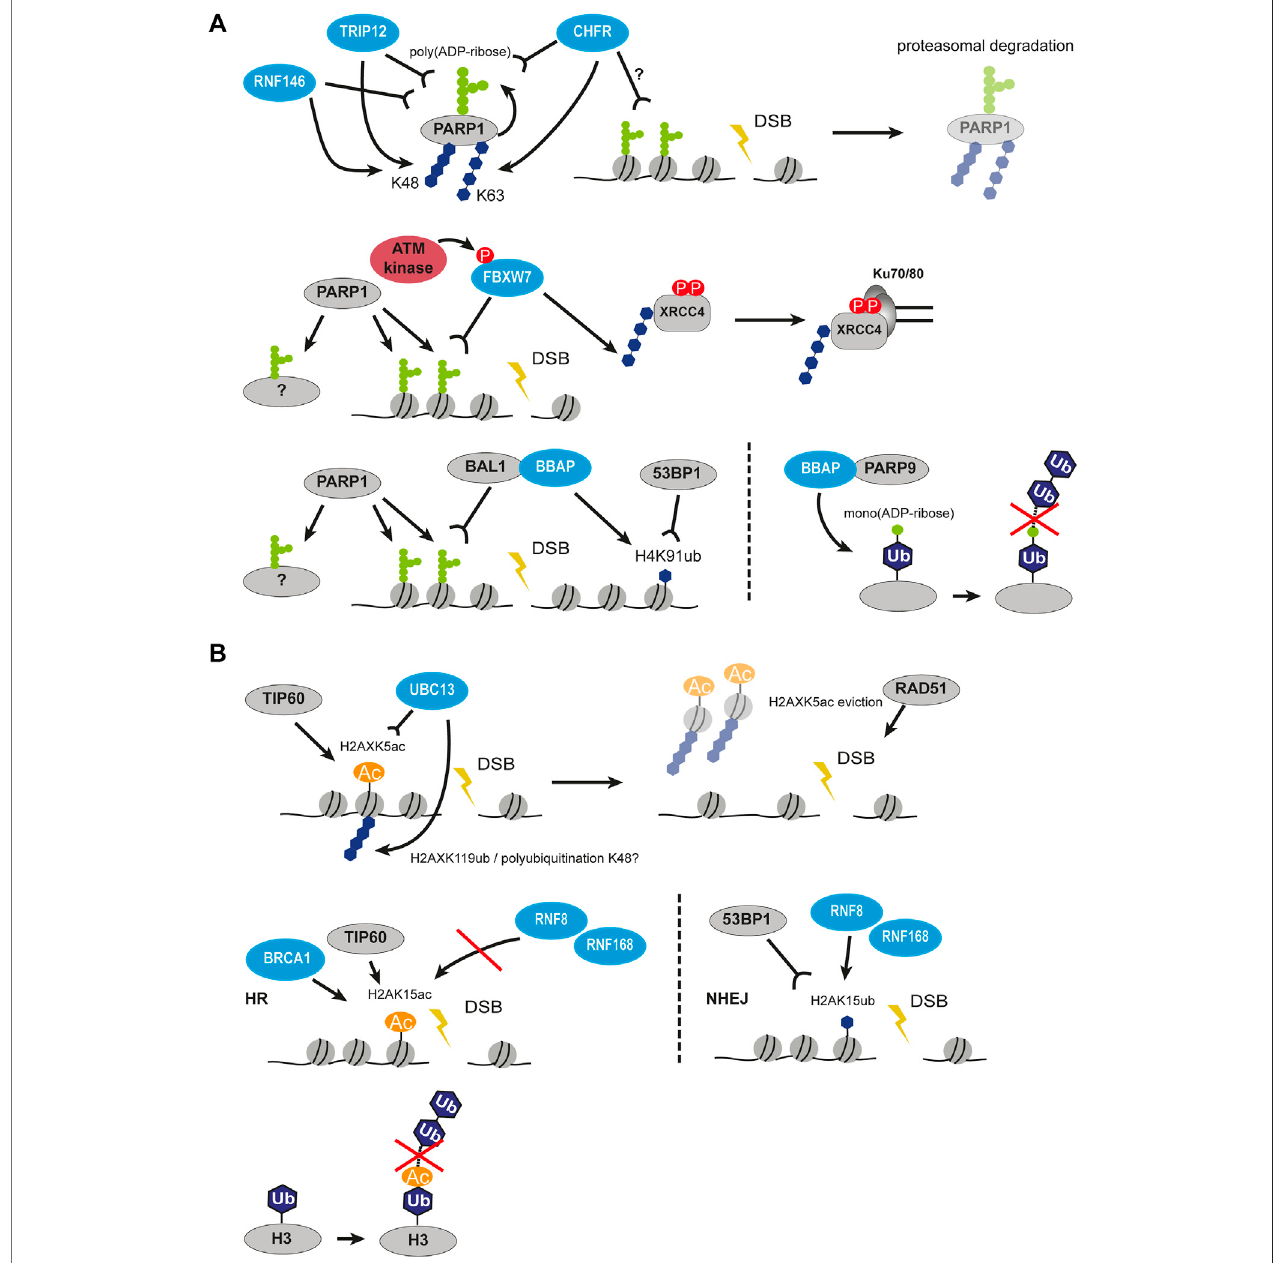
FIGURE 5 | Crosstalk between PARylation and ubiquitination, as well as acetylation and ubiquitination in DSB signaling and repair. (A) Crosstalk between PARylation and ubiquitination. PARP1 auto-PARylates itself followed by recognition of PAR chains by several ubiquitin ligases such as CHFR, RNF146, TRIP12 and subsequent polyubiquitination. This results in proteasomal degradation of PARP1. PARP1-mediated modi fi cation of histones at DSBs can be recognized by FBXW7, whichpolyubiquitinates XRRC4 and leadstoits interaction with Ku70/80. On theother hand,PARP1-mediated modi fi cation ofhistonescanalso berecognized by BAL1-BBAP which leads to ubiquitination of H4K91 creating a binding site for 53BP1. Interaction of BBAP with PARP9 leads to mono(ADP-ribosyl)ation of ubiquitin moiety preventing elongation of ubiquitin chain. (B) Crosstalk between acetylation and ubiquitination. TIP60 acetylates H2AXK5 creating a recognition site for UBC13, whichthenpolyubiquitinatesH2AXK119resultinginevictionofH2AX.H2AK15canbeacetylatedorubiquitinated.WhenacetylatedbyTIP60,itisrecognizedbyBRCA1 but prevents the action of RNF8/RNF168, thus promoting HR. When ubiquitinated by RNF8/RNF168, it is recognized by 53BP1 promoting NHEJ. Acetylation of the ubiquitin moiety similarly to mono(ADP-ribosyl)ation prevents elongation of ubiquitin chain. P, phosphorylation, Ac, acetylation, Ub, ubiquitin.